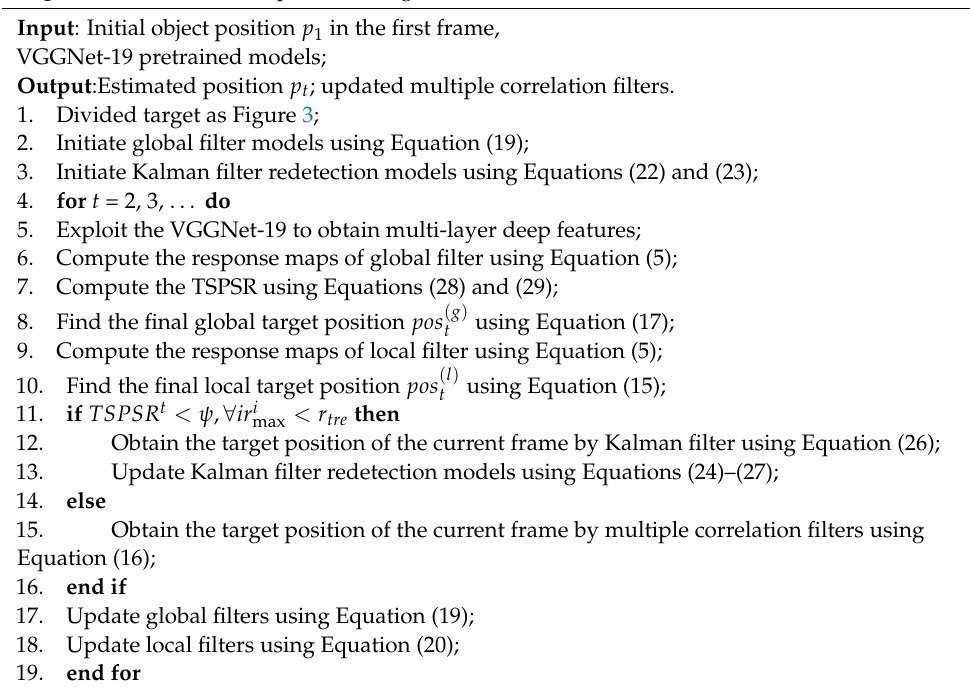
Algorithm 1 The Main Steps of Our